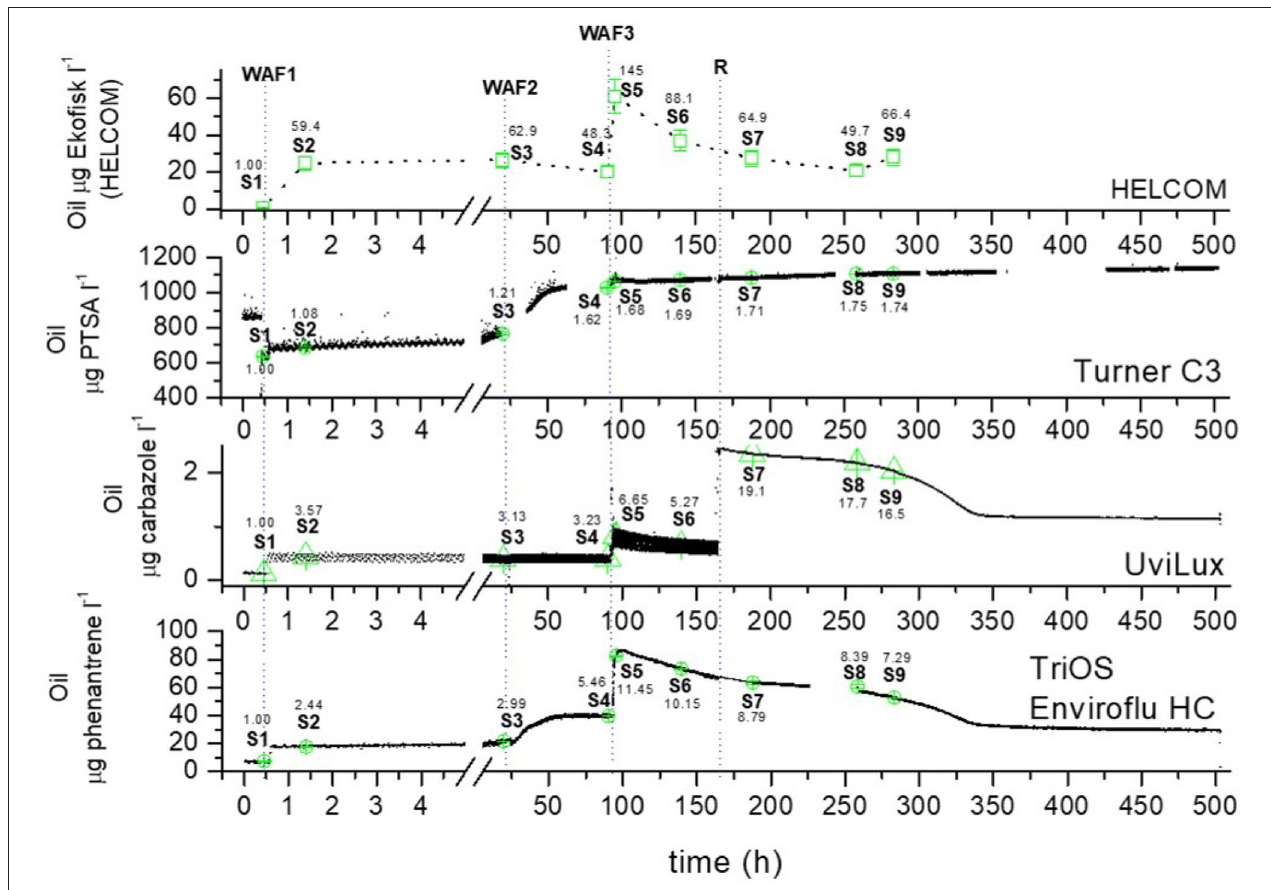
FIGURE 7 | Evolution of responses of fluorescence signals obtained in experiment two over 503.2 h originating from HELCOM reference method (top), Turner C3, UviLux and EnviroFlu-HC (bottom). S1–S9: water sampling events; WAF1–WAF3: events of WAF addition; R: relocation of the sensors. Normalized response values relative to the initial background level (at S1) measured before just before S events are indicated above each S